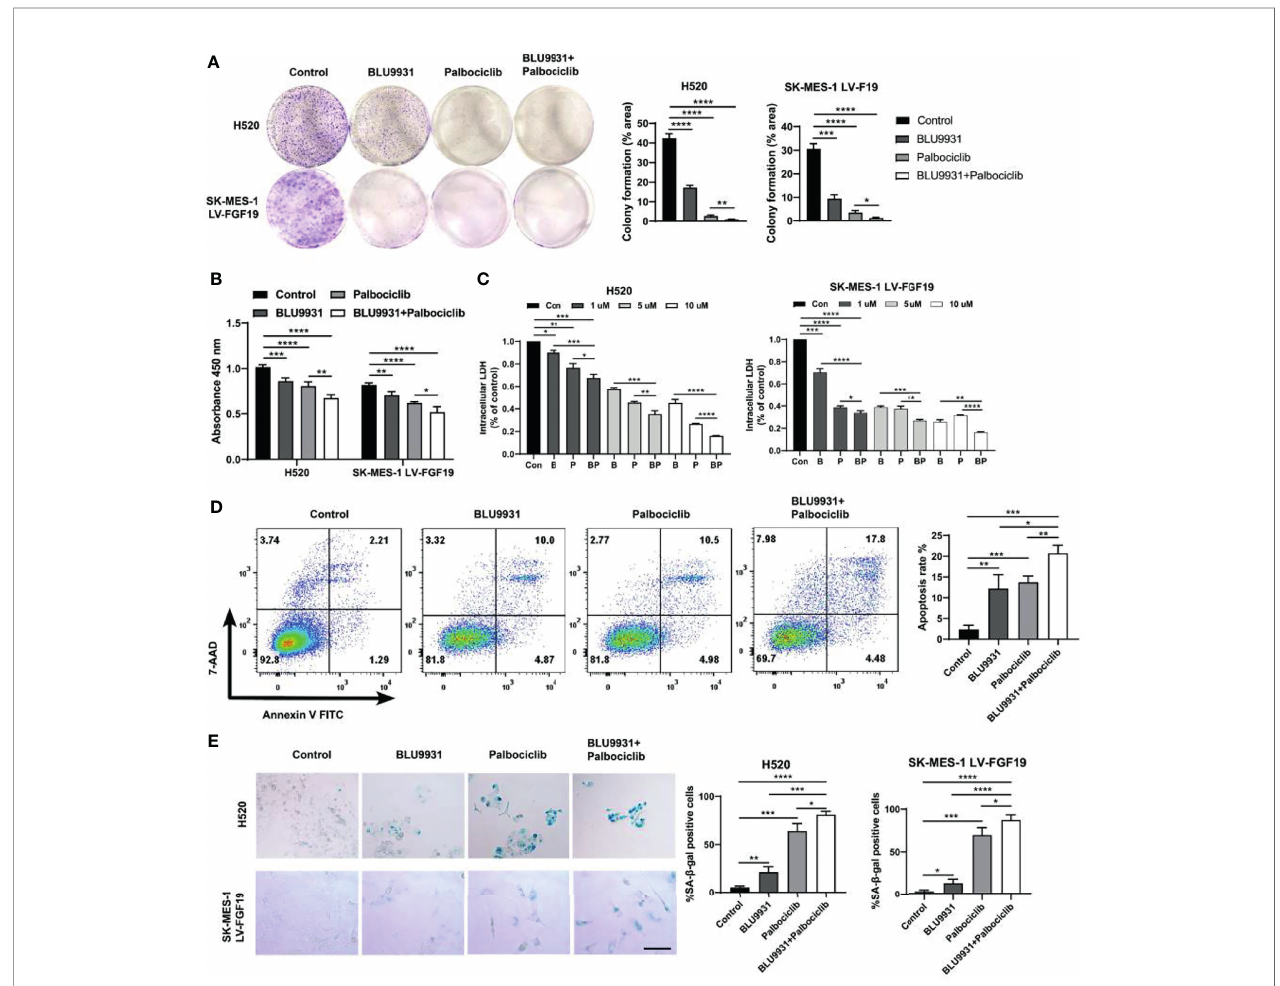
FIGURE 6 | Enhanced effects of combined BLU9931 and palbociclib in LUSC cells in vitro . (A) Cells were plated at a low density in 6-well plates, treated with DMSO, BLU9931, palbociclib, or a combination of the two compounds for 7 – 10 days. (B) CCK8 cell viability assay, (C) Intracellular lactate dehydrogenase (LDH) assay, (D) fl ow cytometry analysis and (E) b -galactosidase staining assay of H520 and SK-MES-1 LV-FGF19 cells treated with a single agent (BLU9931 or palbociclib) or a combination of both compounds at a fi xed ratio (1:1). * p < 0.05; ** p < 0.01; *** p < 0.001; **** p < 0.0001; 100